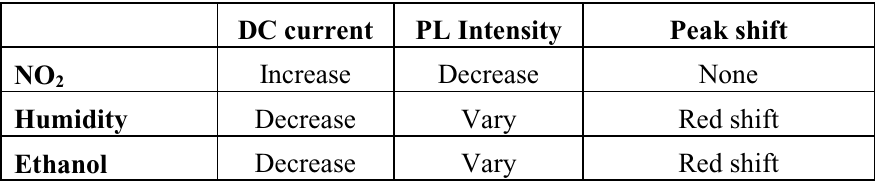
Table 1. Effect of gases on 3 parameters of Porous Silicon